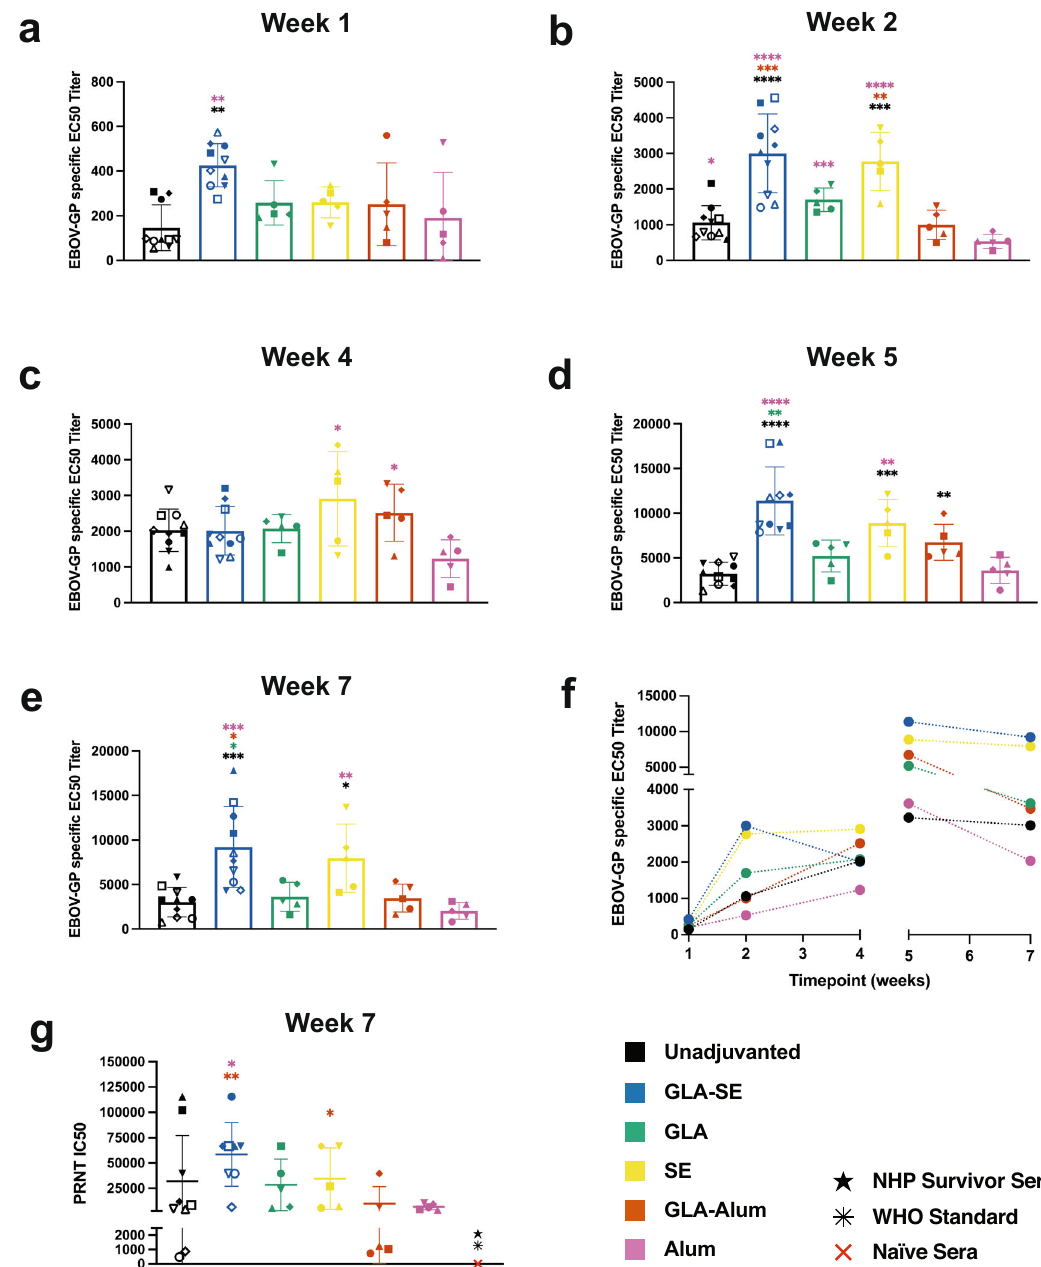
Fig. 1 Adjuvant comparison of anti-EBOV-GP serum antibody titers post-immunization with RABV-vectored FILORAB1 vaccine. a EBOV- GP speci fi c antibody ELISA of sera from C57BL/6 mice immunized with a prime-boost schedule at day 0 and week 4 with FILORAB1 unadjuvanted or with GLA-SE, SE, GLA-alum, or alum at 1 week, b 2 weeks, c 4 weeks, d 5 weeks, and e 7 weeks post-immunization reported as average half-maximal effective concentration (EC50) titer (bars) determined from individual mouse serum (symbols) ELISA curves. f EBOV-GP speci fi c antibody responses over time from 1 to 7 weeks post-immunization separated by the boost immunization at week 4. g Neutralizing antibody titers at week 7 reported as half-maximal inhibitory concentration (IC50) of serum dilution. NHP survivor sera (black star) is pooled from a previous EBOV challenge experiment. The WHO standard (black asterisk) consists of convalescent plasma pool. Error bars represent the standard deviation (SD) from the mean. Statistics are by one-way ANOVA with post hoc Tukey ’ s test of log-transformed EC50 or IC50 titers. p > 0.1234 (ns), p < 0.0332 (*), p < 0.0021 (**), p < 0.0002 (***), p < 0.0001